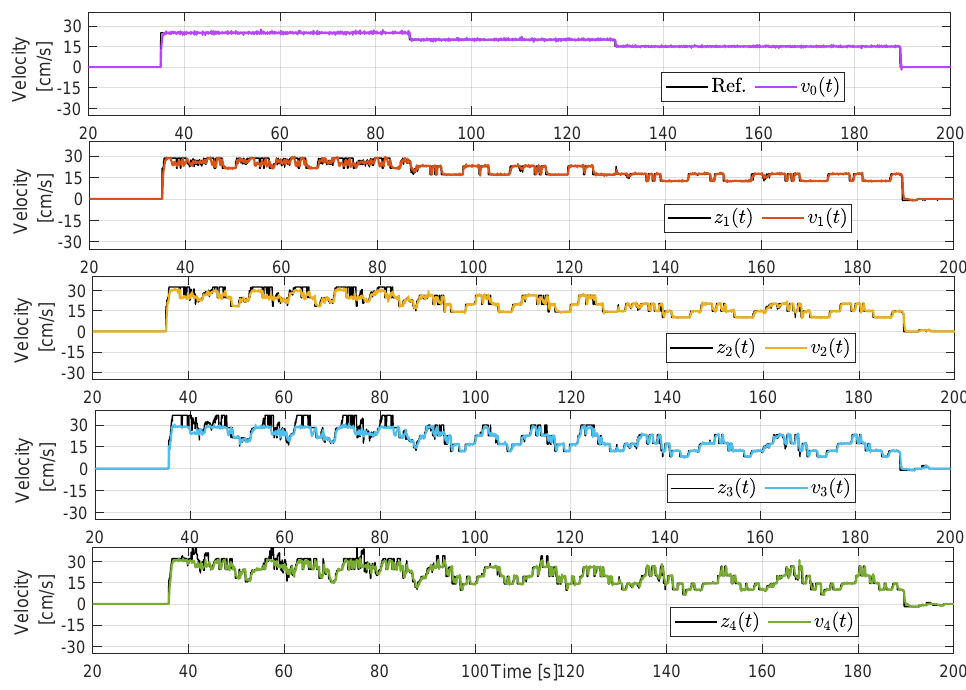
Figure 12. Velocity tracking using the cooperative